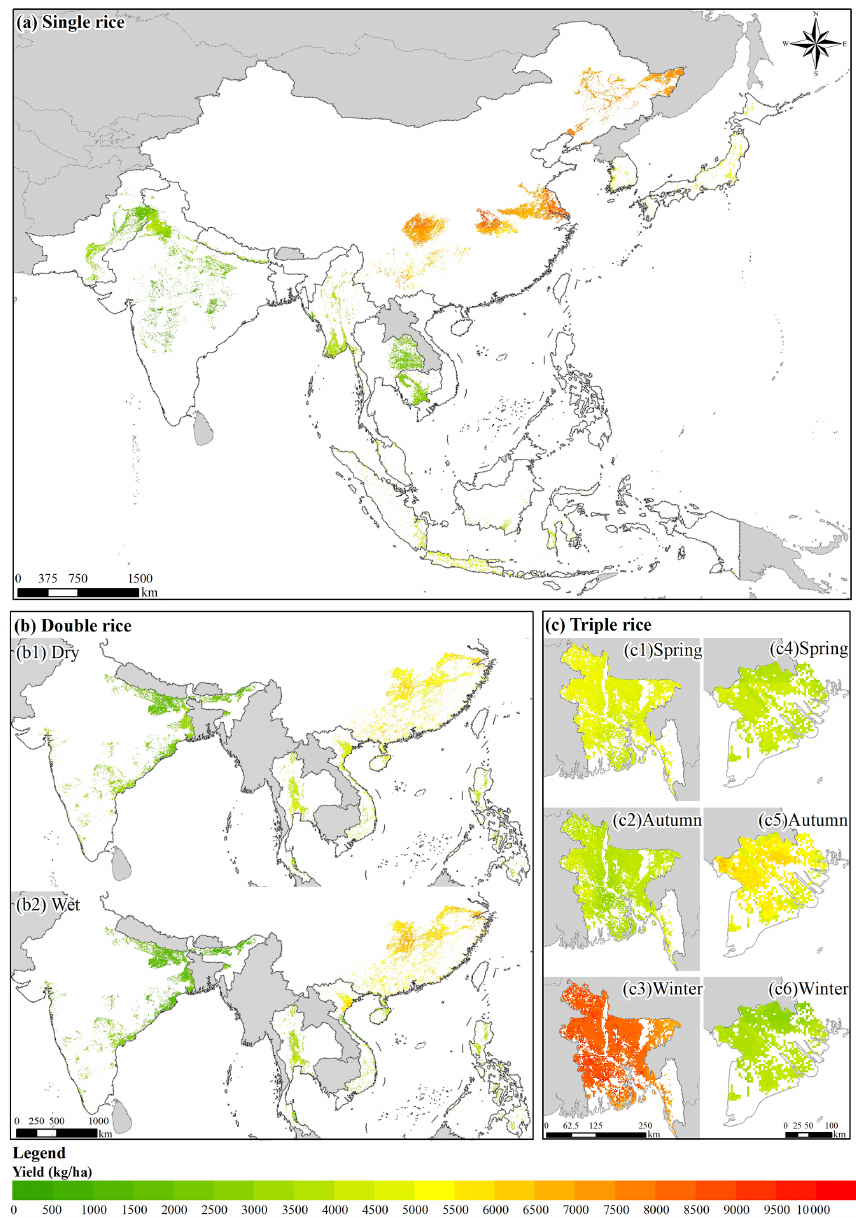
Figure 7. Spatial patterns of the estimated rice yields (averages for the 1995–2015 period) for different seasons.